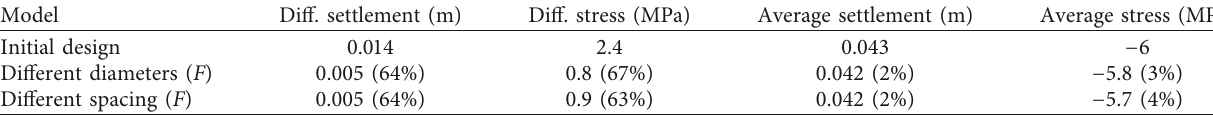
Table 9: Comparison of settlements and stresses on top of piles between different schemes.